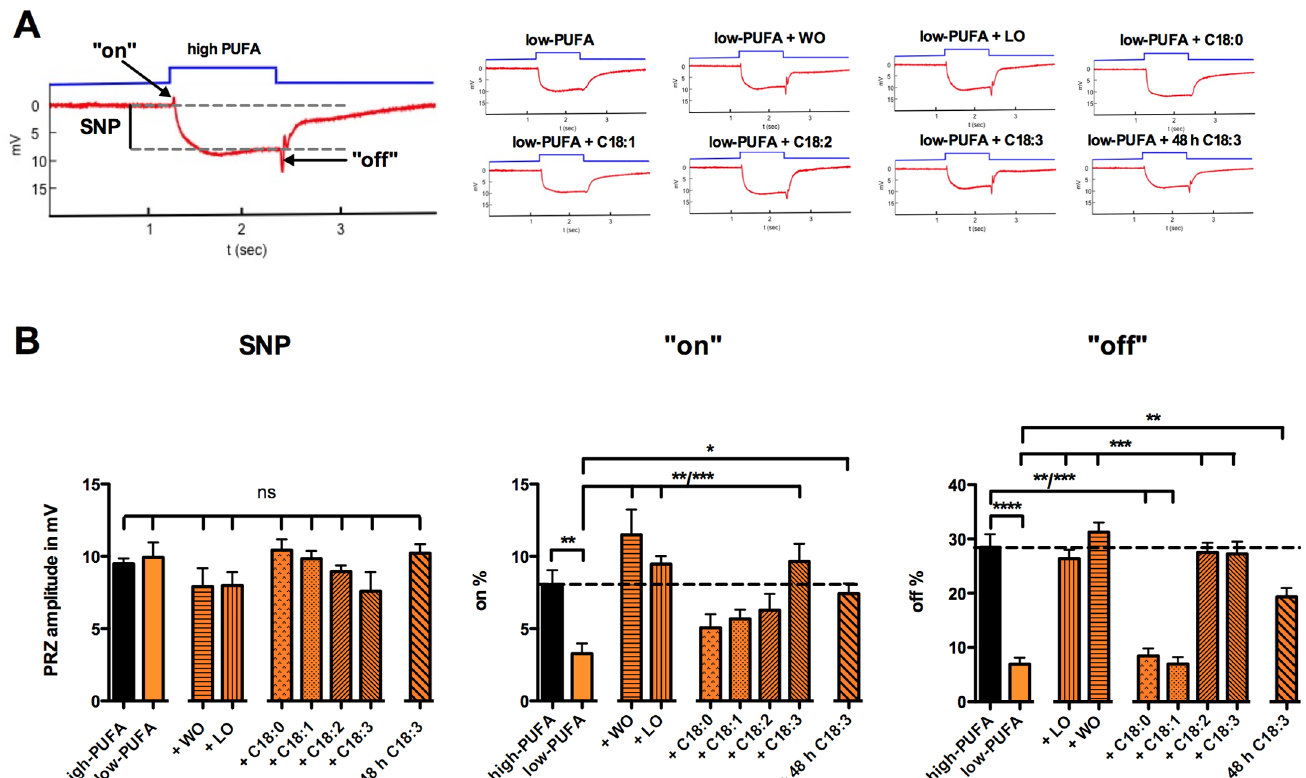
Fig 3. Lack of essential PUFAs causes defects in visual signal transmission. (A) Representative traces of electroretinographic recordings (ERGs). (B) Quantification of the sustained negative potential (SNP) reveals no nutrition-related differences in photoreceptor depolarization. “ on ” - and “ off ” - responses were significantly decreased in flies raised on the low-PUFA diet in comparison to flies raised on the high-PUFA diet (Mann-Whitney test; ** p < 0.05 or **** p > 0.0001, respectively). The “ on ” -response could be rescued by adding either C18:3, WO, or LO to the low-PUFA diet (KW-test; ** p < 0.01 or *** p < 0.001). Adding either WO, LO, C18:2, or C18:3, to the low-PUFA diet rescued the “ off ” response (KW-test; *** p < 0.001). Both defects in the “ on ” - and the “ off ” -responses of flies raised on the low-PUFA diet could be rescued with 48h of adult diet on high-PUFA + C18:3 (KW-test; p * < 0.05 or p ** < 0.01, respectively). Data represent mean ± SEM. (N = 10, ns: p > 0.05). The significance levels indicate the results of the applied post-hoc tests. Detailed information about statistical values can be found in table ST3C, D and,